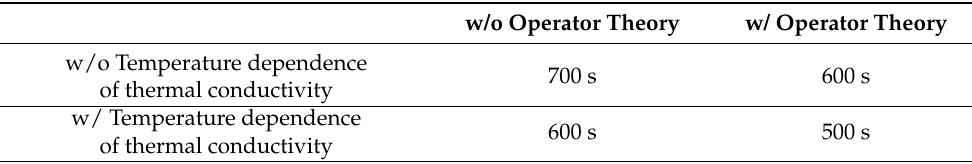
Figure 15. Endothermic quantity of Peltier device u c at 15 W (w/ operator theory). Table 7. Time until the u c follows the Q in